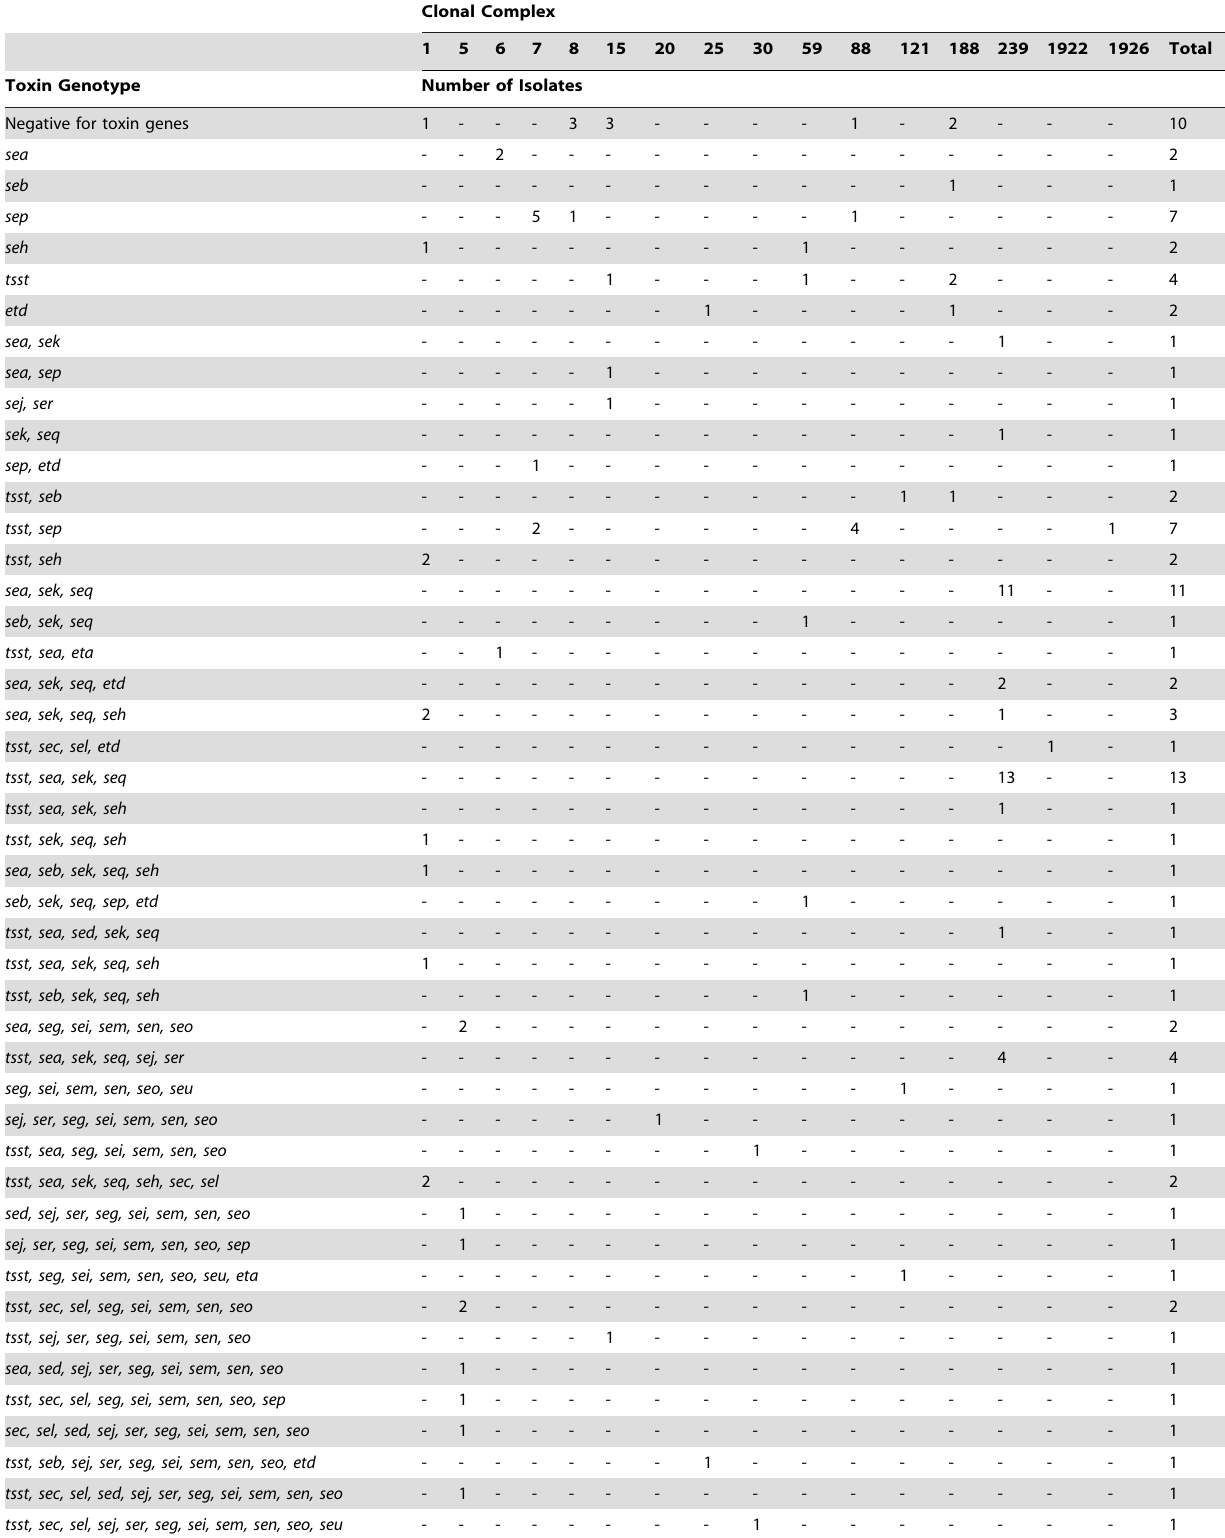
Table 1. Toxin genotypes of S. aureus isolates in different clonal complexes.